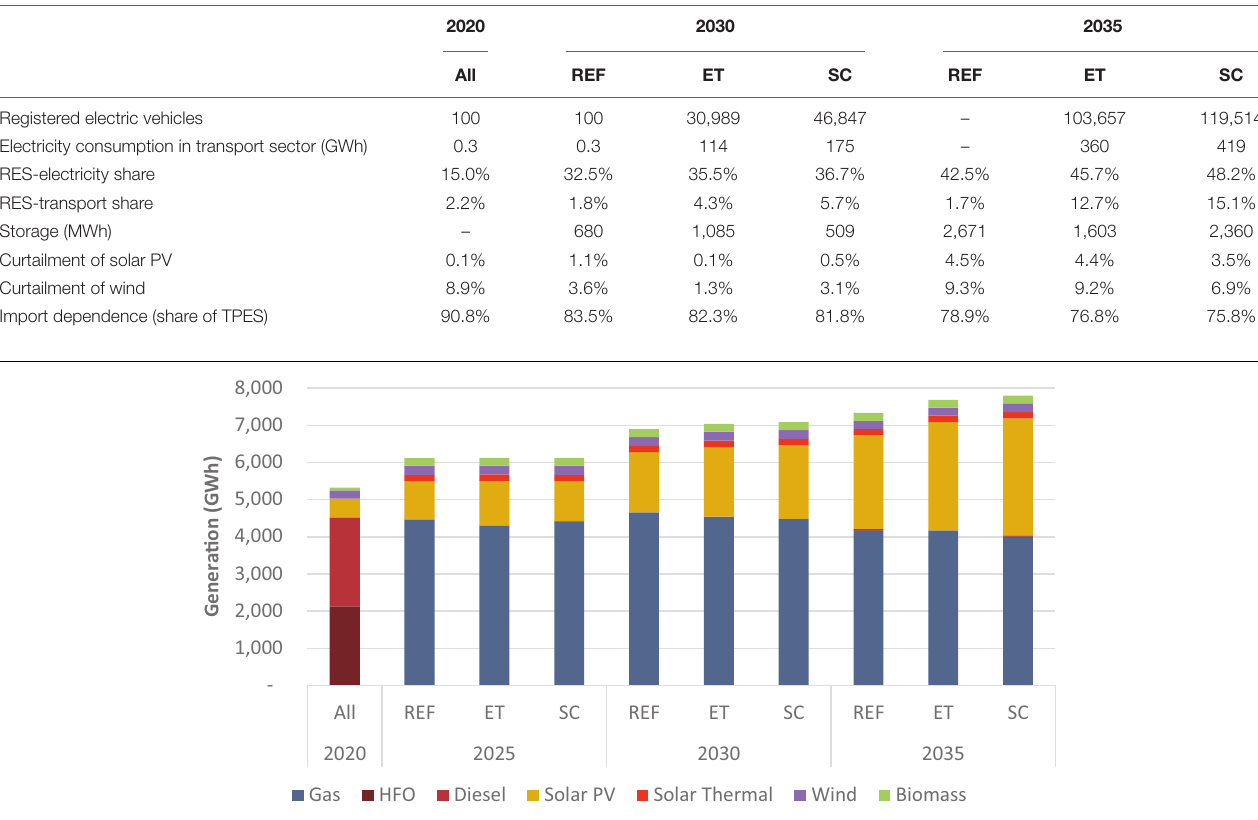
FIGURE 2 | Evolution of generation by technology in each of the three scenarios. Marginal differences are observed between the scenarios, even though generation from renewable energy sources gradually increases as we move from the REF to the ET and the SC scenario. The total amount of electricity generation is noticeably higher in the ET and SC scenarios, as compared to the REF scenario, in 2035 and to a lesser extent in